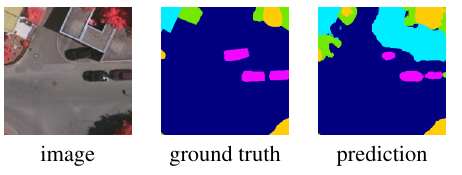
Figure 5: Labeling errors in the ground